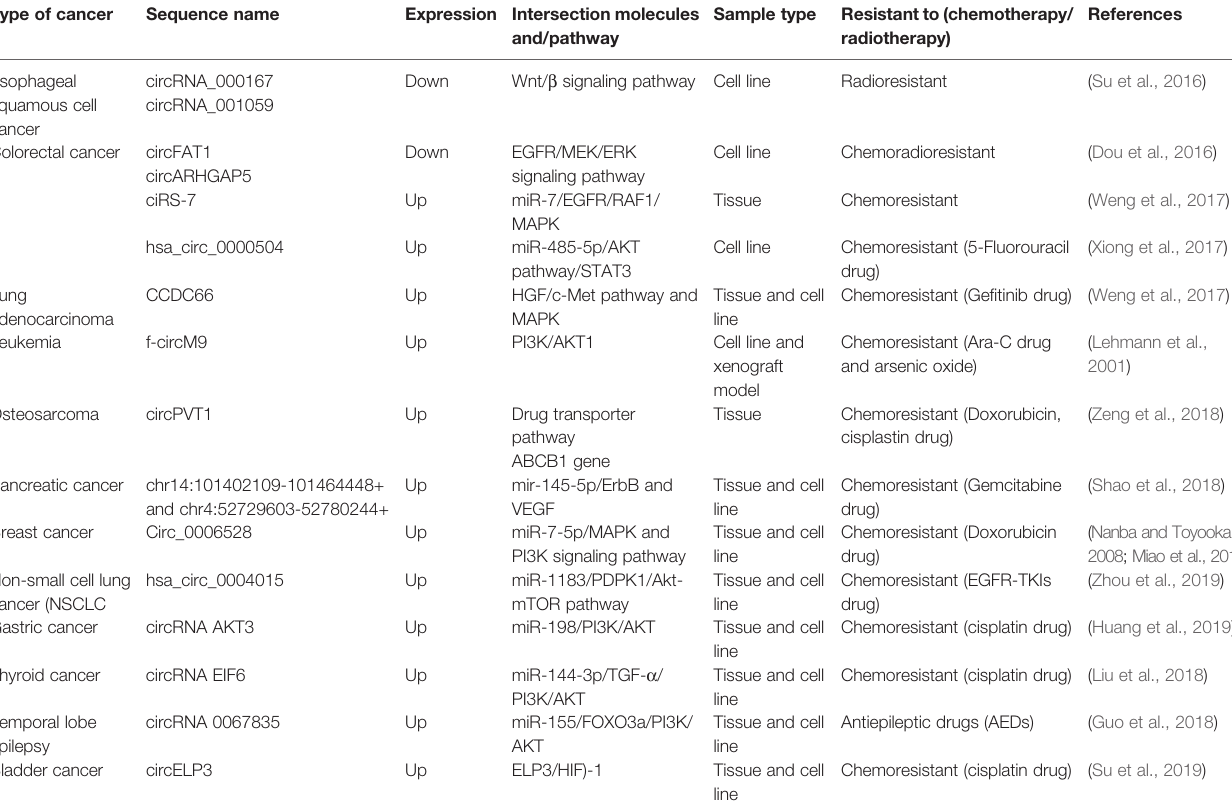
TABLE 1 | List of CircRNAs involved in treatment resistance in human